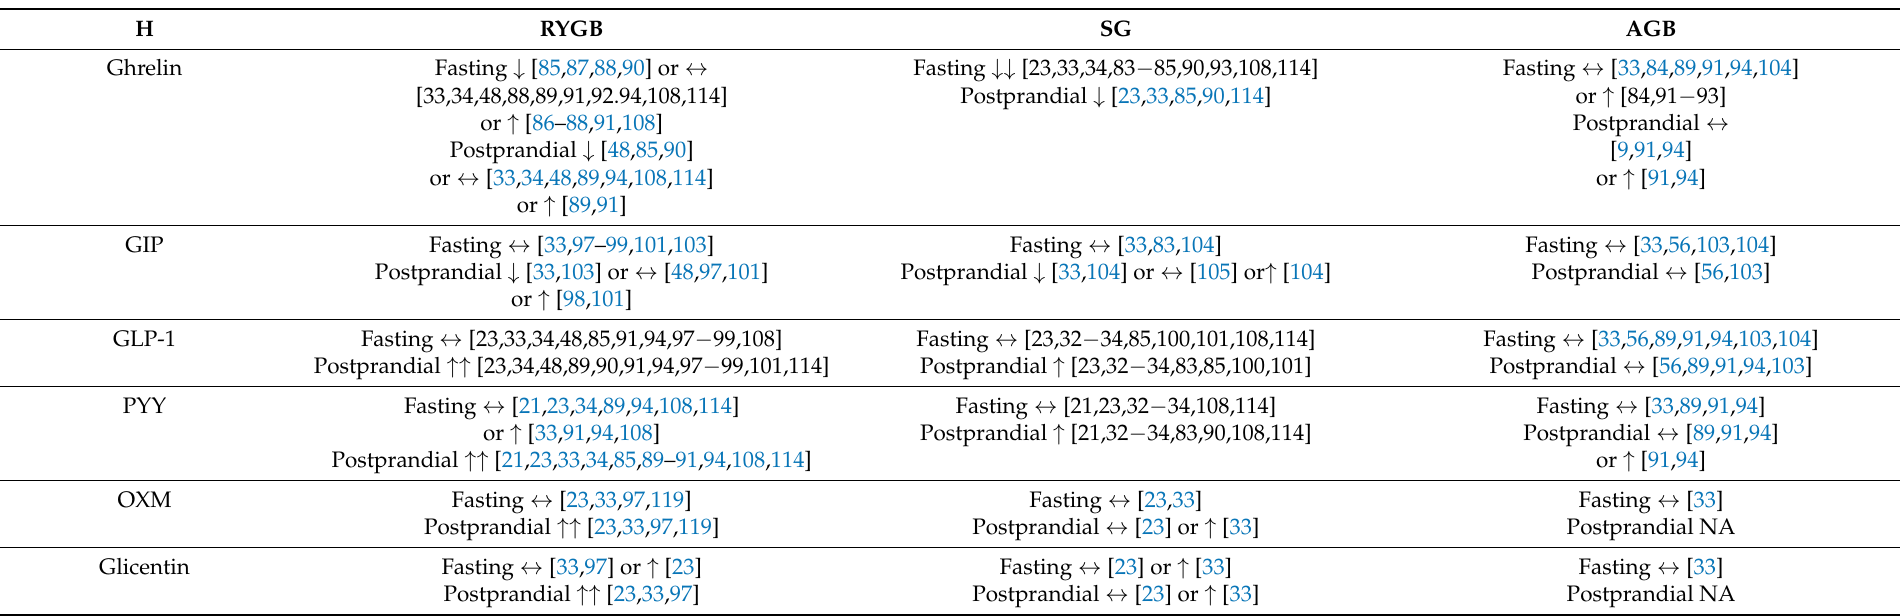
Table 1. Changes in gut hormones after the most commonly performed bariatric